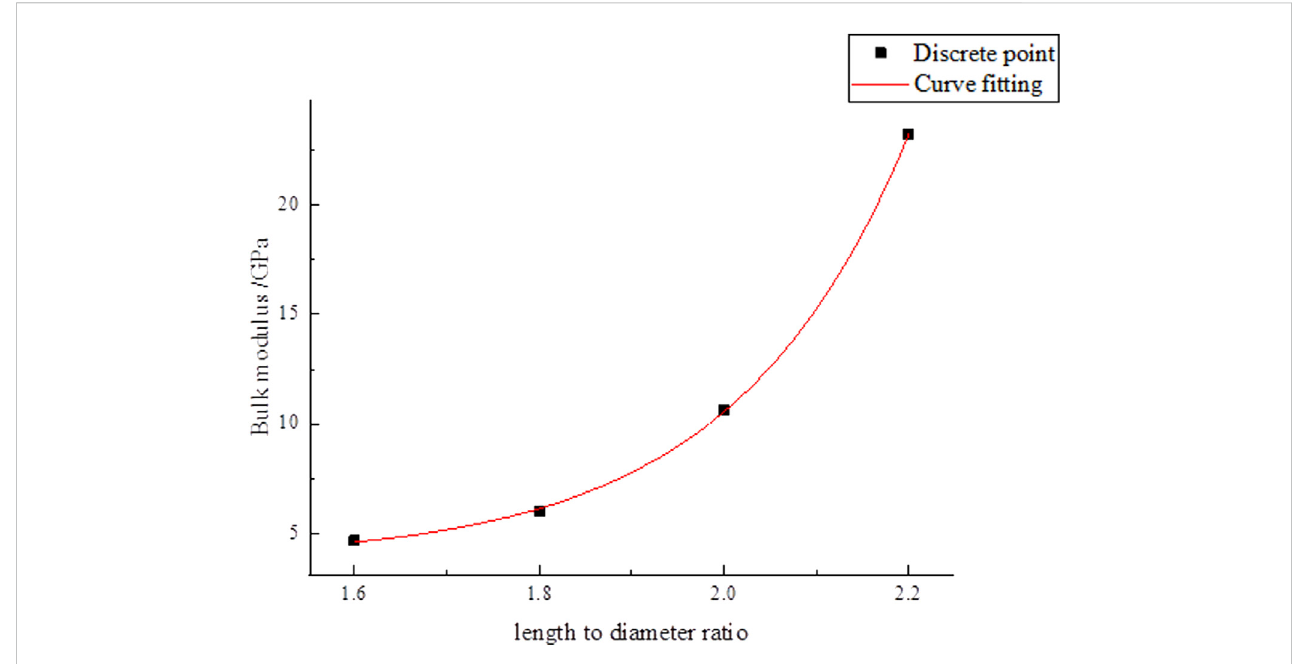
FIGURE 11 Fitting curves of bulk modulus and length to diameter